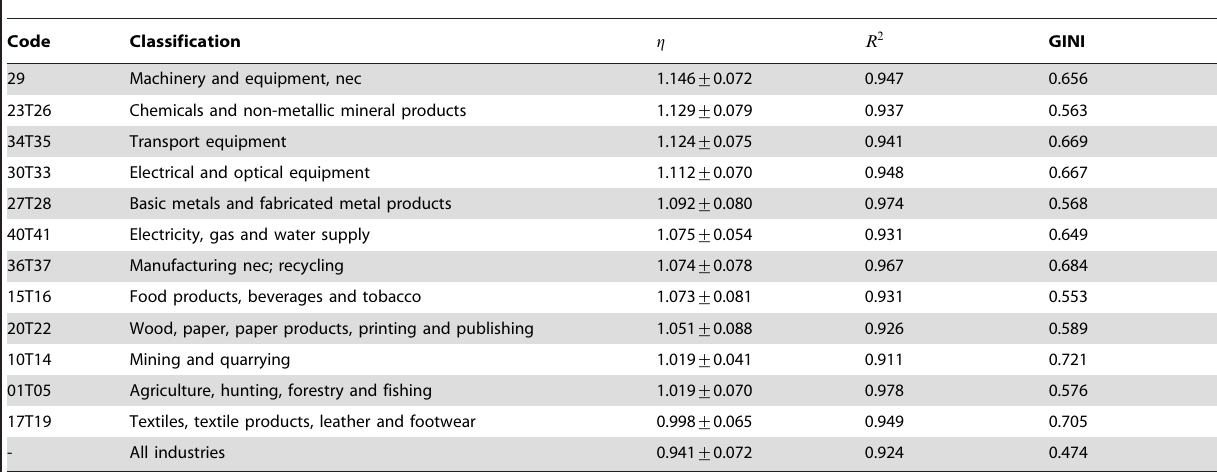
Table 2. Exponents for different products in OECD data set.